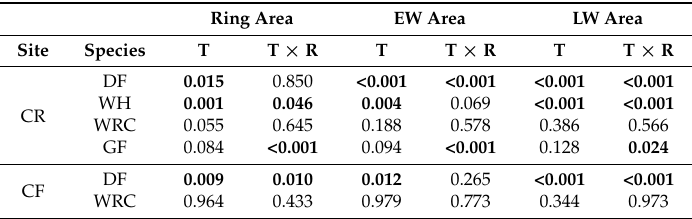
Table 4. Adjusted p -value from the ANOVA test of fixed effects for the different sites and species for treatment (T) and the interaction-effect treatment x ring (T × R) regarding ring area, earlywood (EW) area, and latewood (LW) area for Douglas-fir (DF), western hemlock (WH), western redcedar (WRC), and grand fir (GF) trees growing under contrasting vegetation management treatments on sites located in the Cascade foothills (CF) and central Coast Range (CR) of western Oregon. Bold : result is statistically significant at p < 0.05. Ring Area EW Area LW Area